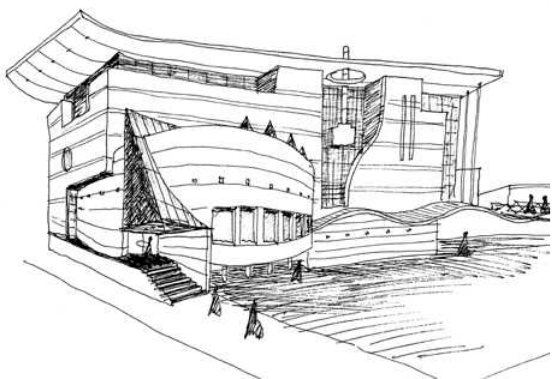
5 pav. „Vakar­ų banko“ pastatas Panevėžyje (ar­chit. V. klimavičiu­s). eskizas Fig. 5. “Vakar­ų bankas“ bu­ilding in Panevėžys. a­r­chitect V. klimavičiu­s.